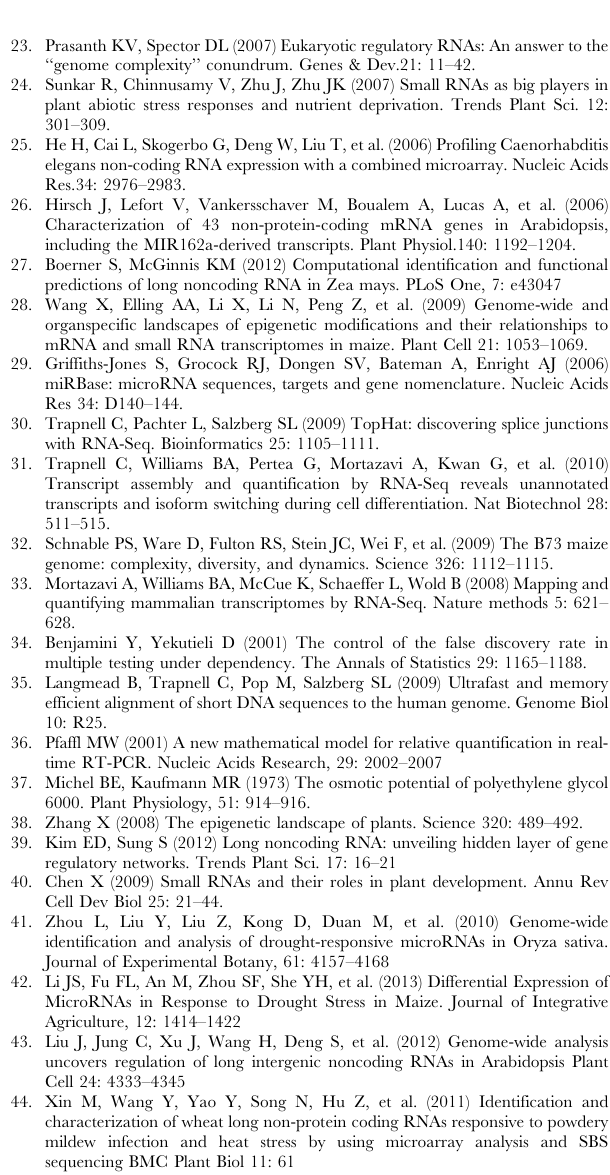
Table S1 Primers used in this study. Table S2 The expression of 664 lncRNA in control and drought stress leaves.